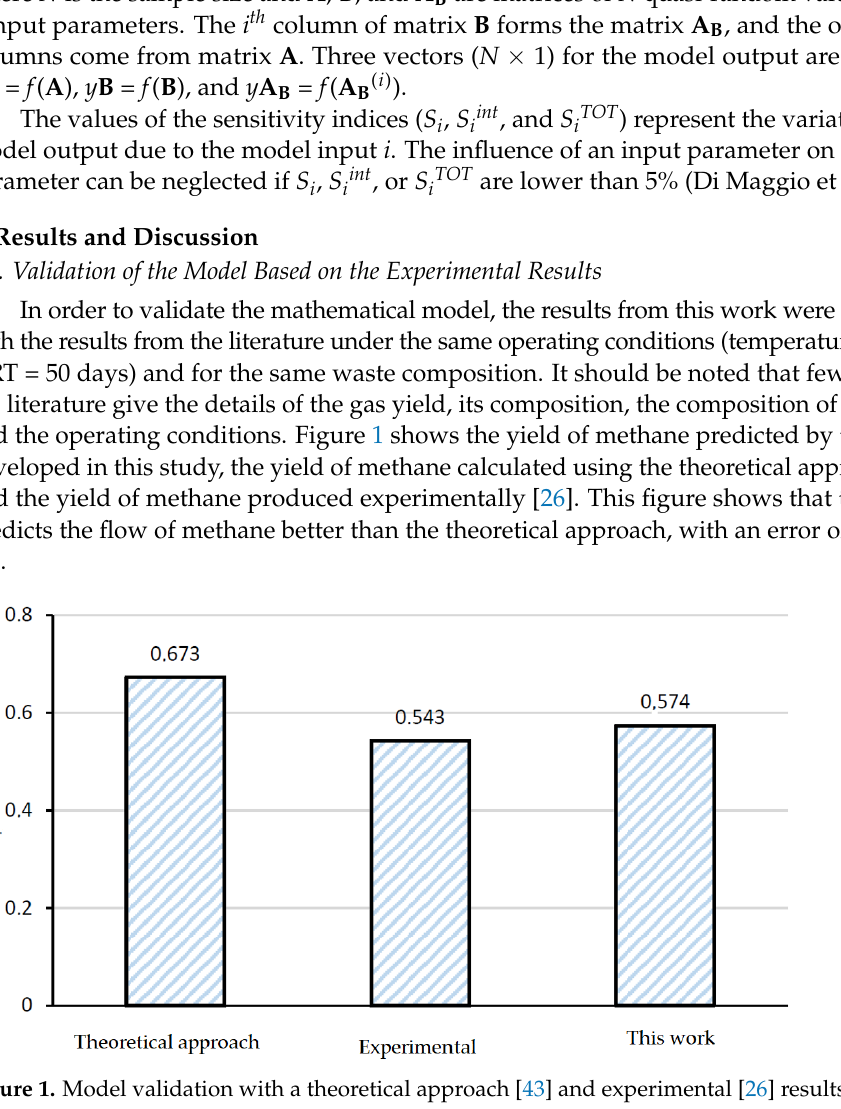
Table 3. Parameters and their ranges considered for the GSA for the bioreactor.